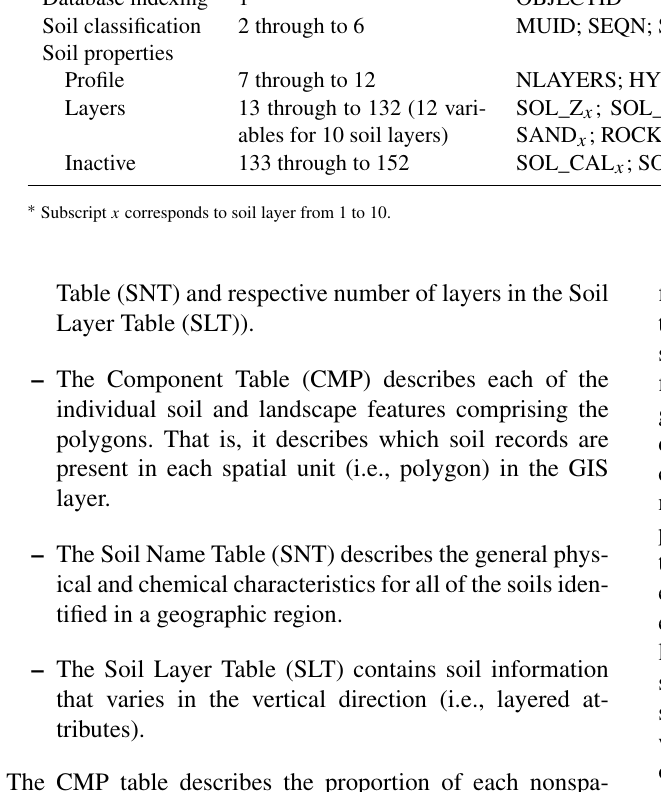
Table 1. Description of variables in SWAT’s “usersoil” table.